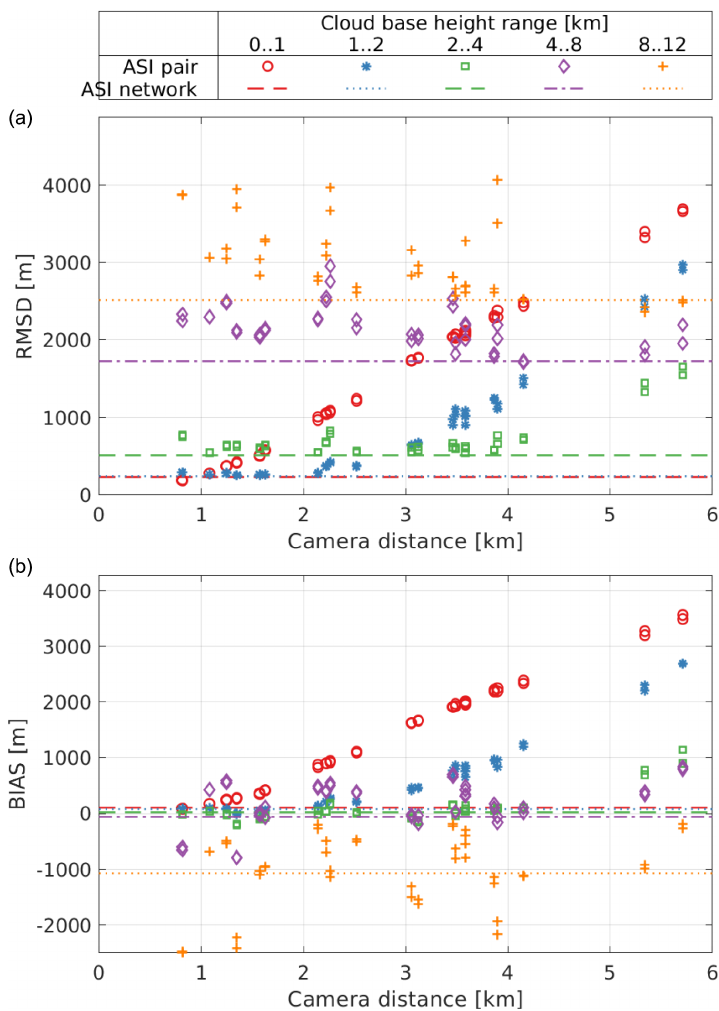
Figure 11. RMSD (a) and bias (b) received by 42 ASI pairs utilizing camera distances in the range of 0 . 8 ... 5 . 7km and by the ASI network with refinements (no camera distance applicable) for the period 30 June to 27 September